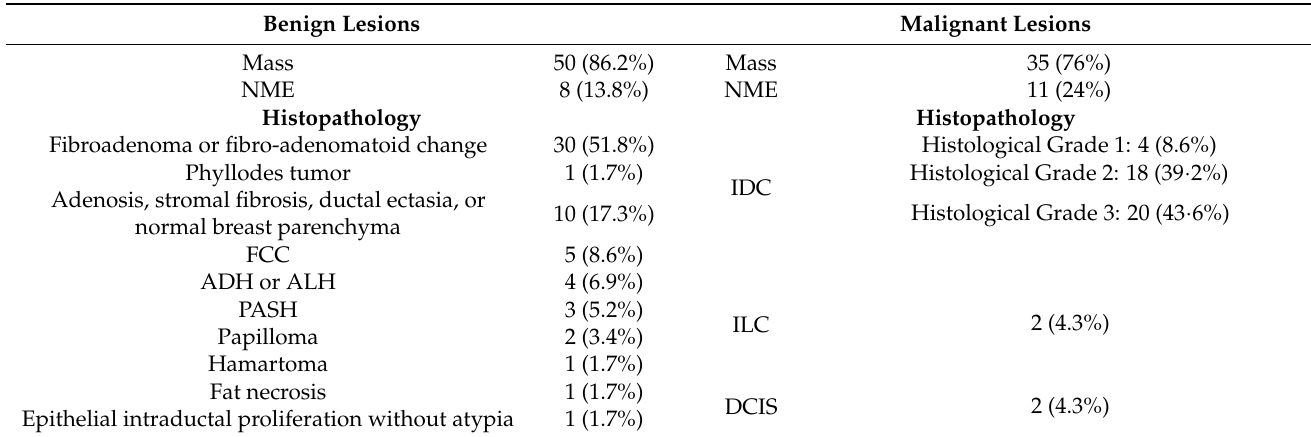
Table 3. Characteristics of the 104 lesions included in the